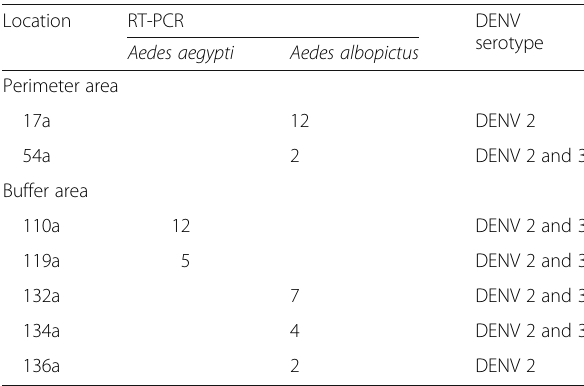
Table 3 Serotypes of dengue virus in Aedes spp. mosquitoes in Adisucipto Airport of Yogyakarta